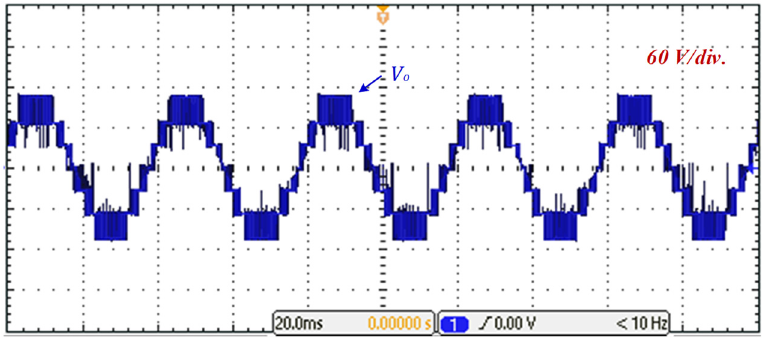
Figure 15. A photograph of the experimental system.